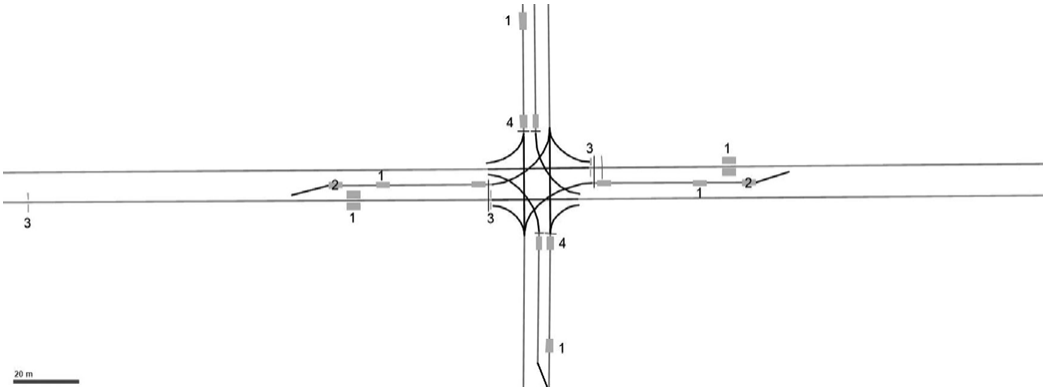
Fig. 8. PTV VISSIM network structure and allocation of detectors